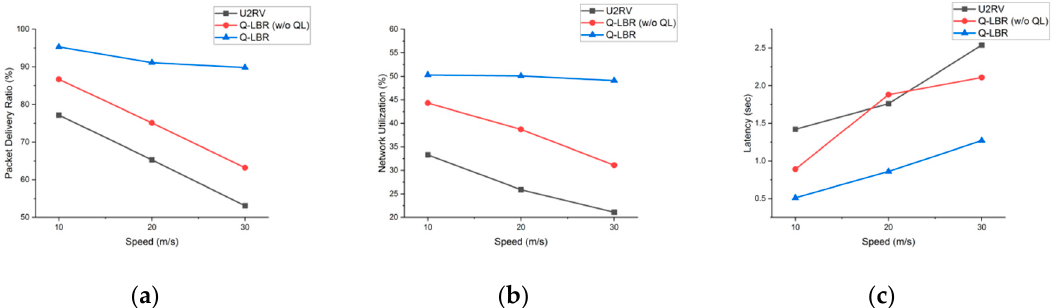
Figure 10. Performance comparison for ground node speed: ( a ) total PDR, ( b ) total network utilization, and ( c ) total latency . Table 3. Simulation results for varying the speed of the nodes (all traffic = 10 r/s).